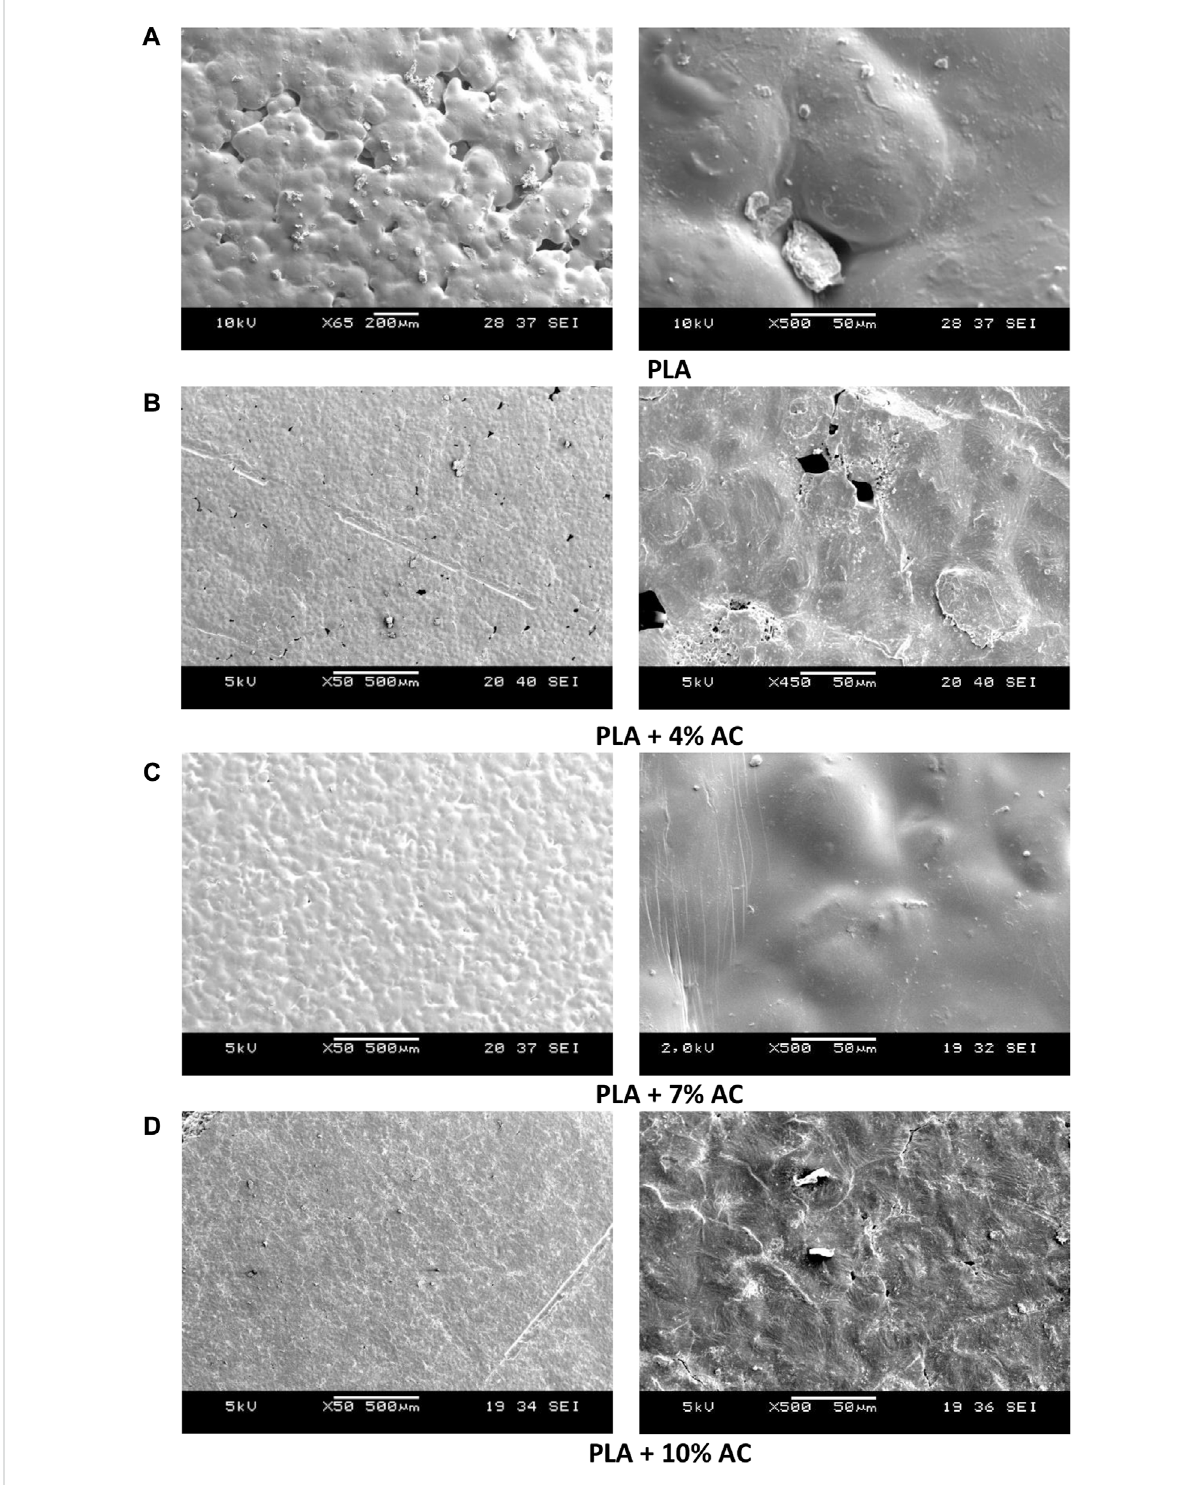
FIGURE 11 SEM micrographs of (A) PLA, (B) PLA+ 4% AC, (C) PLA +7% AC and (D) PLA +10% AC composite at different magni fi